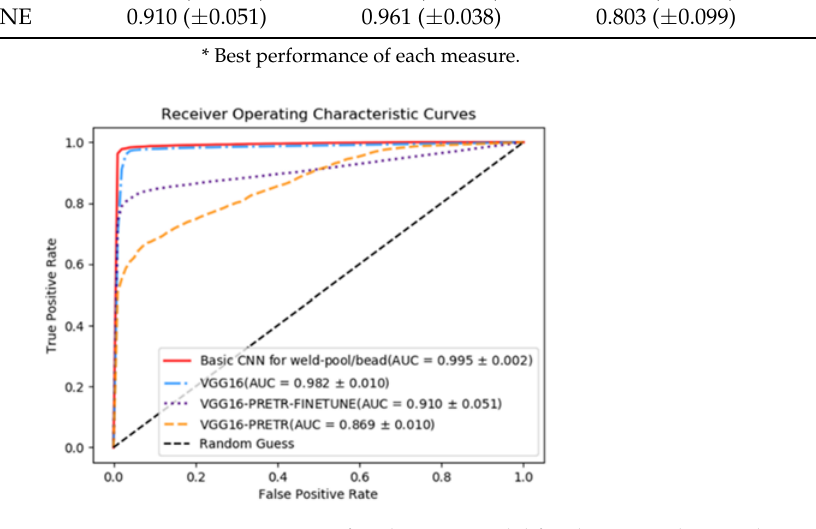
Figure 12. Mean ROC curves of each CNN model for detecting abnormality in